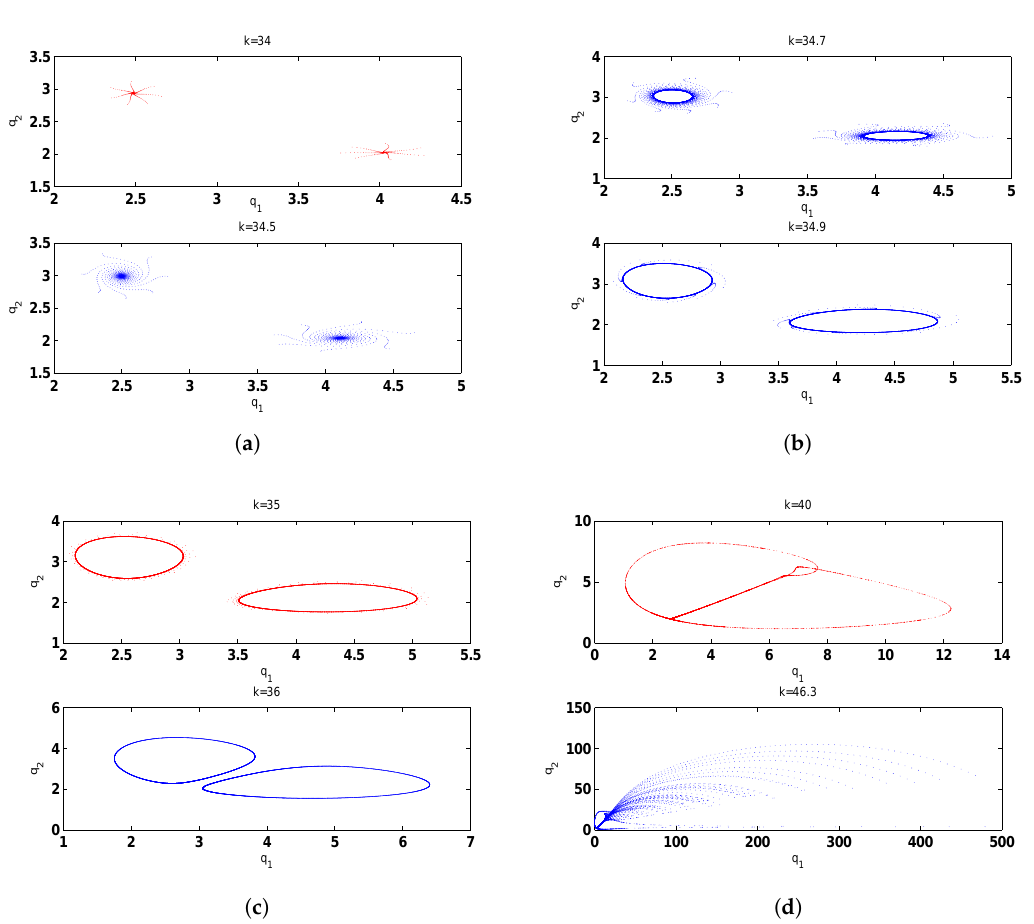
Figure 7. ( a ) k = 34 and k = 34.5; ( b ) = 34.7 and k = 34.9; ( c ) = 35 and k = 36; ( d ) = 40 and k =